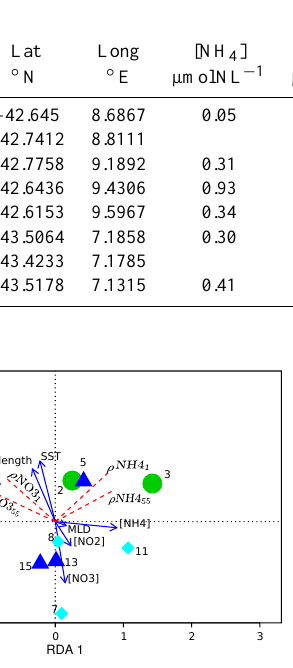
Figure 4. RDA triplot. The blue arrows represent the environmen- tal parameters. The red dashed lines are the response variables. The stations are labelled based on the zone in which they are lo- cated. ρ NO 31 and ρ NO 355 represent ρ NO at the 1 and 55% light 3 depths, respectively, and ρ NH 41 and ρ NH 455 the ρ NH at the same 4 light depths. The uptake rates were log-transformed. SST is the sea- surface temperature, [NO 2 ], [NO 3 ] and [NH 4 ] the concentrations of nitrite, nitrate and ammonium. The numbers for each station are the 15N station numbers. The numbers in the legend represent the CTD (conductivity–temperature–depth)